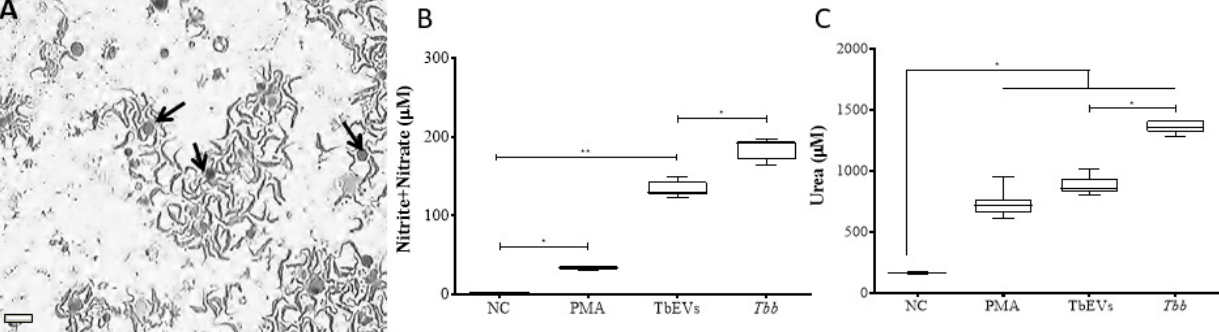
Figure 4. Production of nitric oxide and urea by macrophages exposed to TbEVs. M Φ (arrows) exposed to trypomastigote forms were observed under an inverted light microscope ( A , size bar—20 μ m, ×100 magnification). NO ( B ) and urea ( C ) production were evaluated in M Φ exposed to T. b. brucei ( Tbb ) parasites, in M Φ stimulated by TbEVs and PMA, and in resting-M Φ (negative control, NC). Results of three independent experiments ( n = 12) and two replicates per sample are represented by whiskered box plots, including median, minimum, and maximum values. The non-parametric Wilcoxon matched-pairs signed-rank test was used for statistical comparisons ( p < 0.05). * ( p < 0.05) and ** ( p < 0.01) indicate statistical significance.